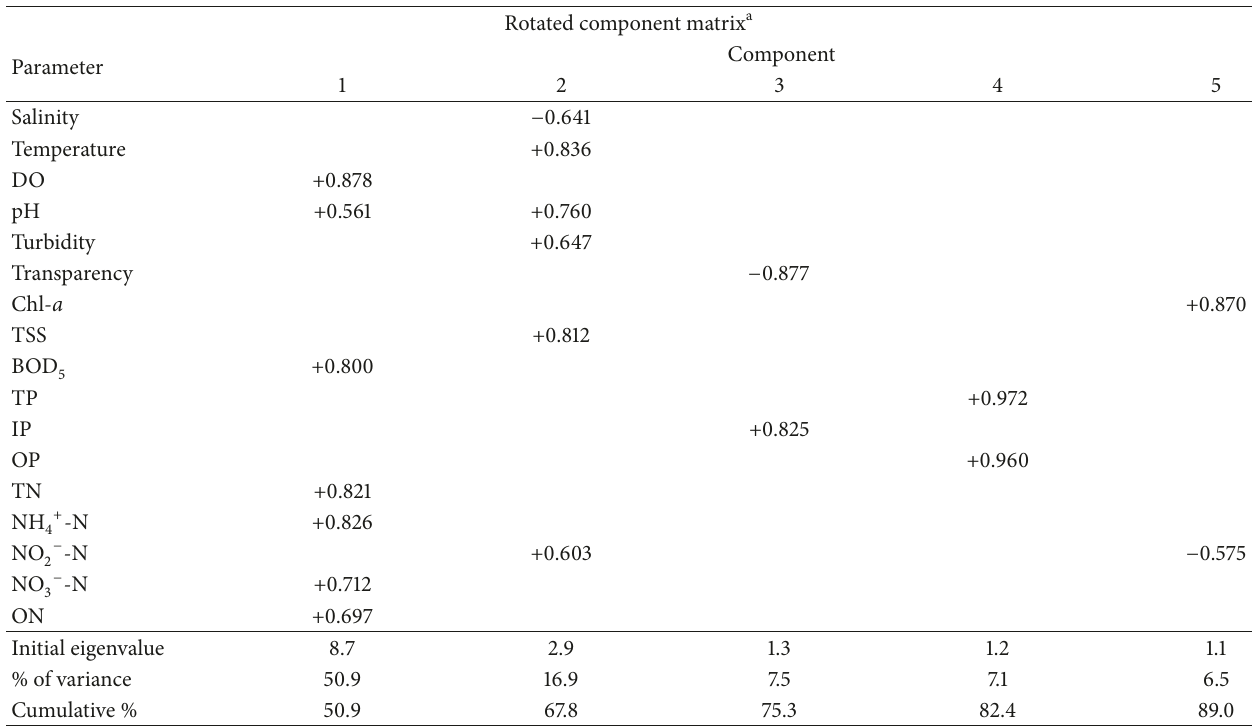
Table 4: Loadings of the in situ and ex situ water quality parameters on the first five Varimax-rotated PCs (eigenvalue > 1) along the coastline of southwestern region